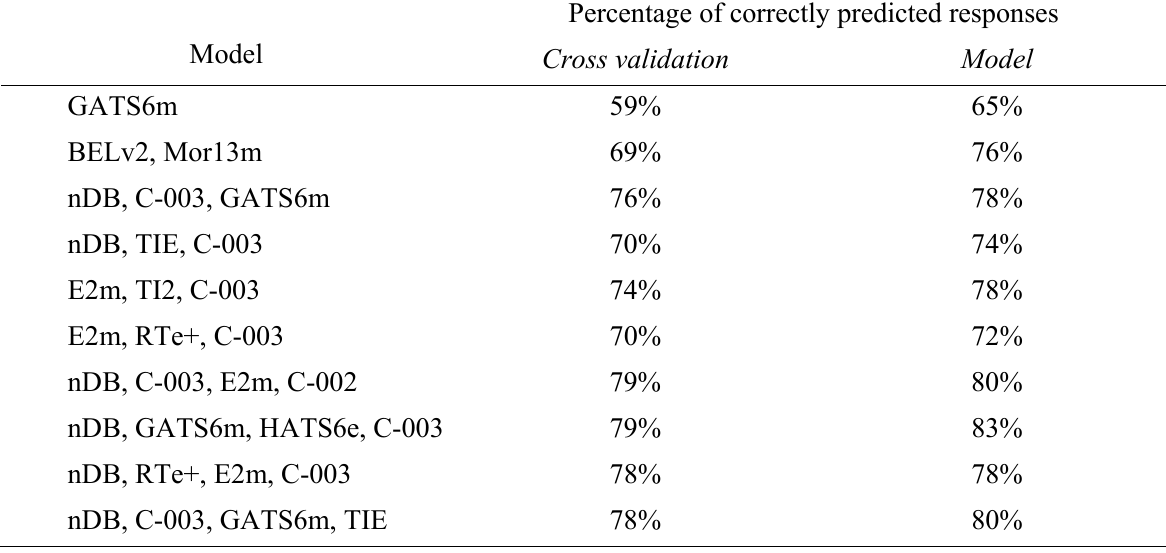
Table 2. Comparison of the best performing logistic models containing 1, 2, 3 and 4 descriptors. Most of presented descriptors are described in Table 1 or in the text, apart from: BELv2, which is a BCUT descriptor weighted by atomic van der Waals volumes; Mor13m, which is a 3D-Morse descriptor weighted by atomic masses; TIE is E-state topological parameter, and C-002 is a counter of CH molecular